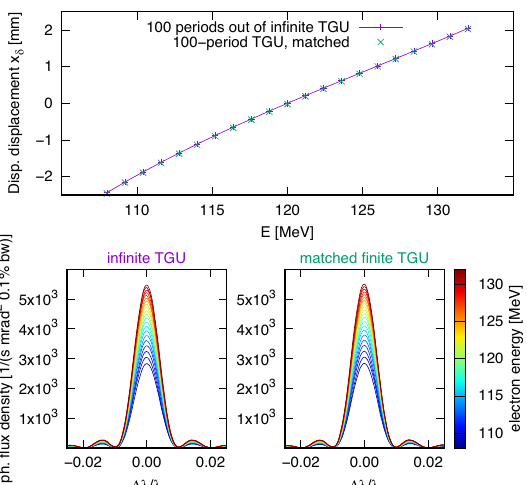
FIG. 7. Comparison of the required dispersion and the resulting radiation spectra (assuming zero-emittance beamlets) between the case of 100 periods out of an infinitely long SCTGU and the case of a finite 100-period SCTGU with matching periods. See the text for